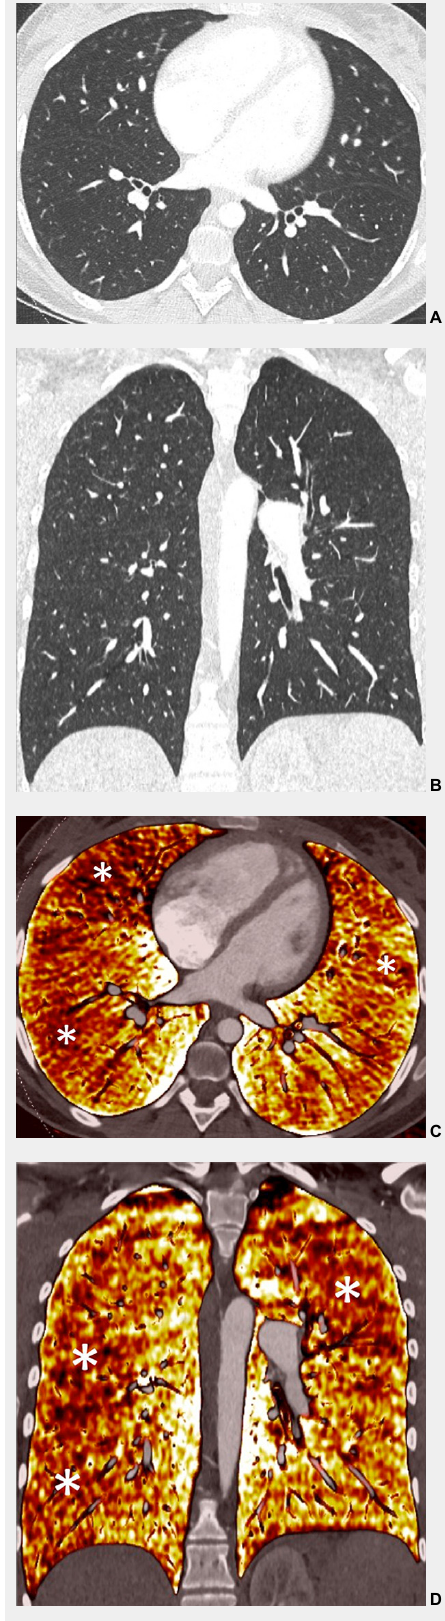
Figure 7 Portopulmonary hypertension in a 16-year-old. No abnormalities were found on morphological computed tomography ( A/B ), but heterogeneous perfusions were present on the perfusion map (stars, C/D